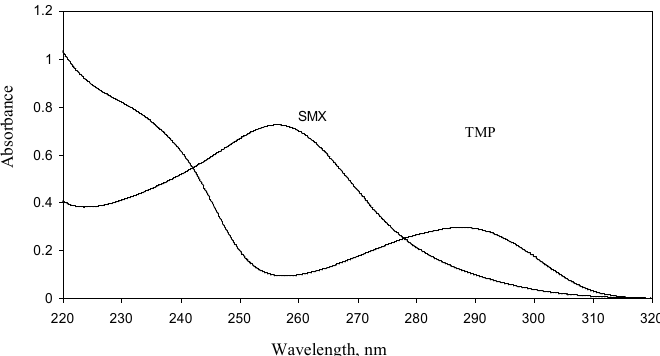
Figure 3. Absorption spectra of (a) 40 µmol L -1 sulfamethoxazole (b) 40 µmol L -1 trimethoprim pH 10.0.